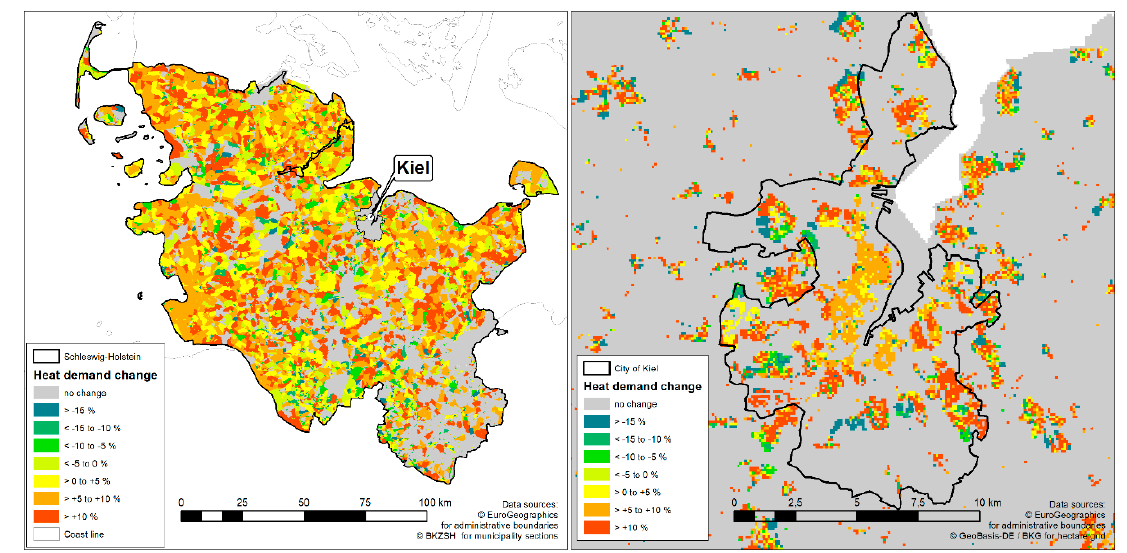
Figure 5. Percental change in annual residential heat demand when modeled with information on residential building construction period on municipality sections ( left ) and hectare grid cells ( right ) in comparison to the base reference model without any information on building age.